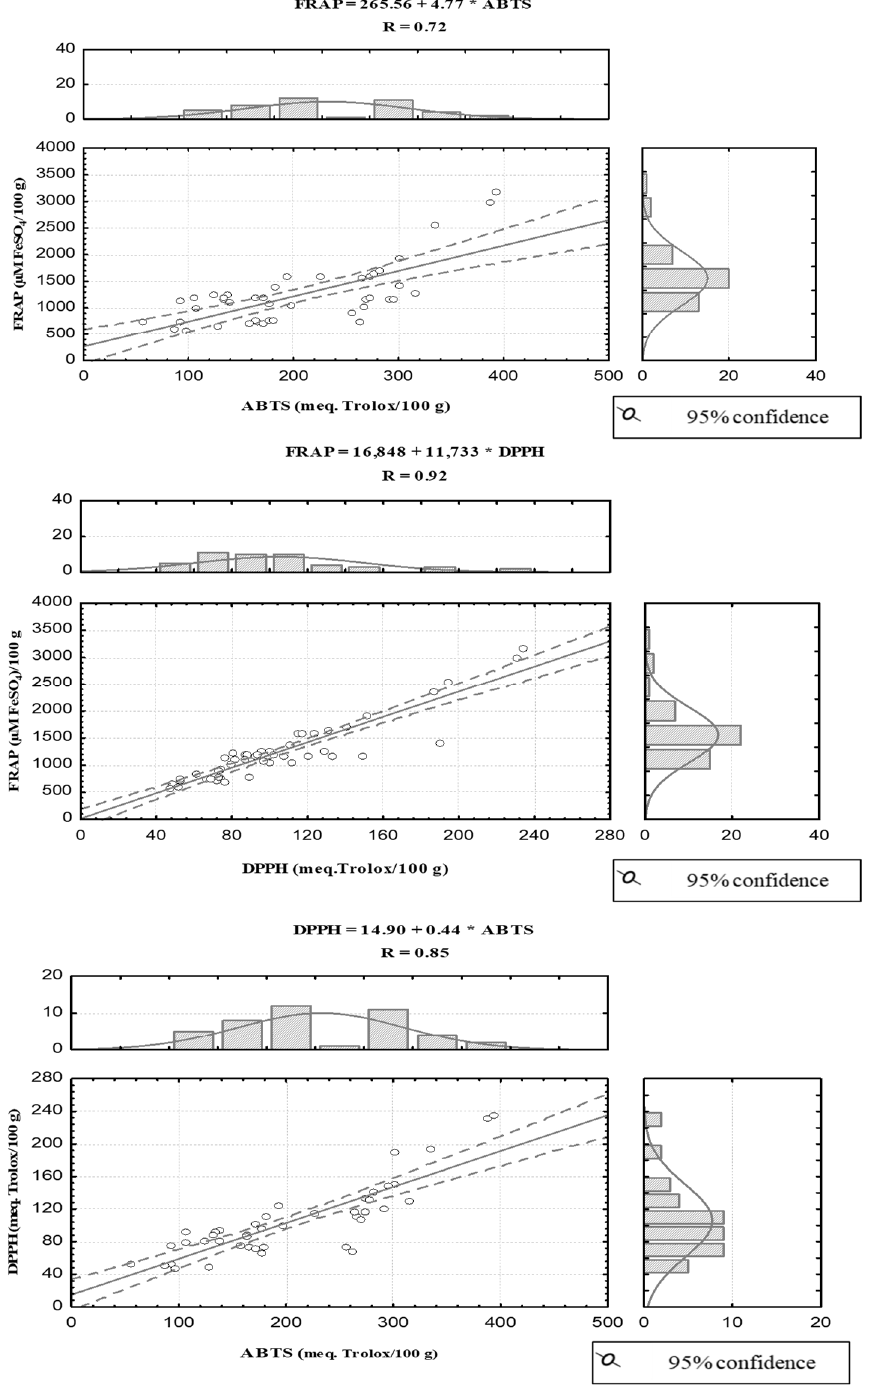
Figure 1. Correlations established between the results of the three antioxidant assays in the chestnut